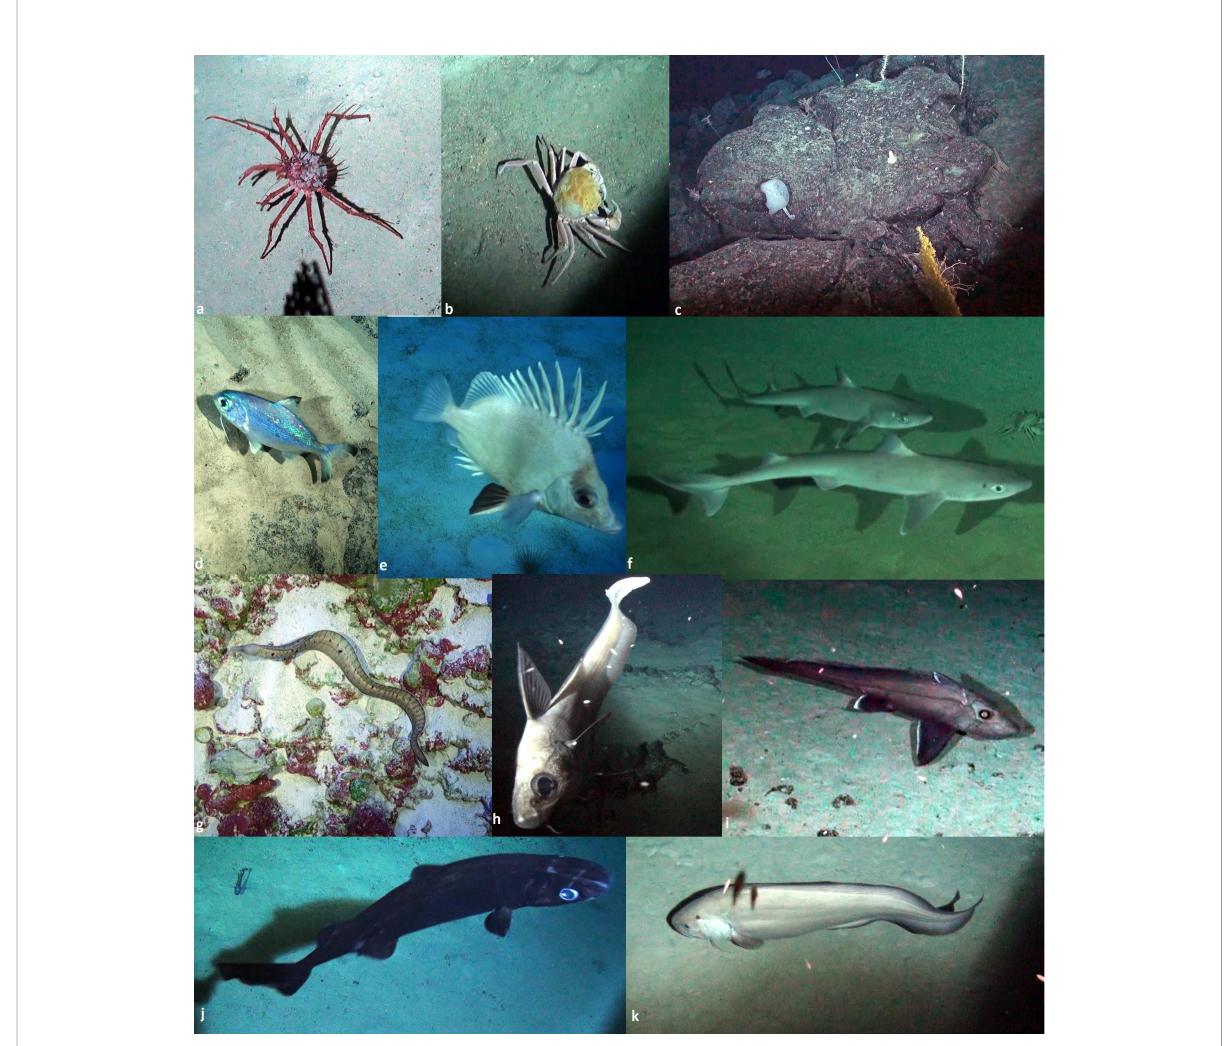
FIGURE 3 Examples of deep-water fauna documented using cost-effective drop cameras during the fi rst ever study that surveyed both ends of the Salas y Go ́ mez and Nazca ridges. From top left to bottom right: (A) Lithodidae , (B) Chaceon chilensis , (C) various deep-sea corals and sponges, (D) Polymixia salagomeziensis , (E) Pentaceros decacanthus , (F) Squalus sp., (G) Gymnothorax bathyphilus , (H) Coryphaenoides sp., (I) Hydrolagus sp., (J) Etmopterus sp., and (K) Spectrunculus sp. (Friedlander et al., 2021; images courtesy of National Geographic Pristine Seas and National Geographic Exploration Technology